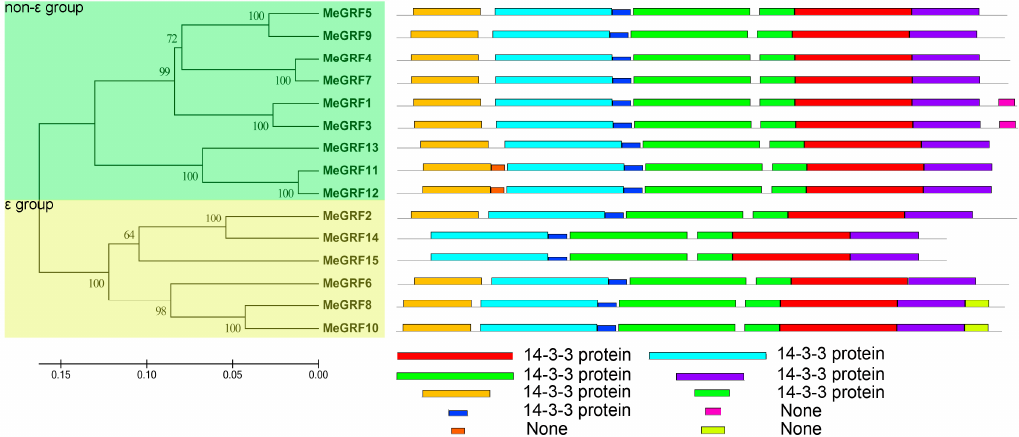
Figure 2. Phylogenetic and motif analyses of cassava GRFs. All cassava GRF protein sequences were determined with MEME software and were classed into two groups based on phylogenetic relationship [48].